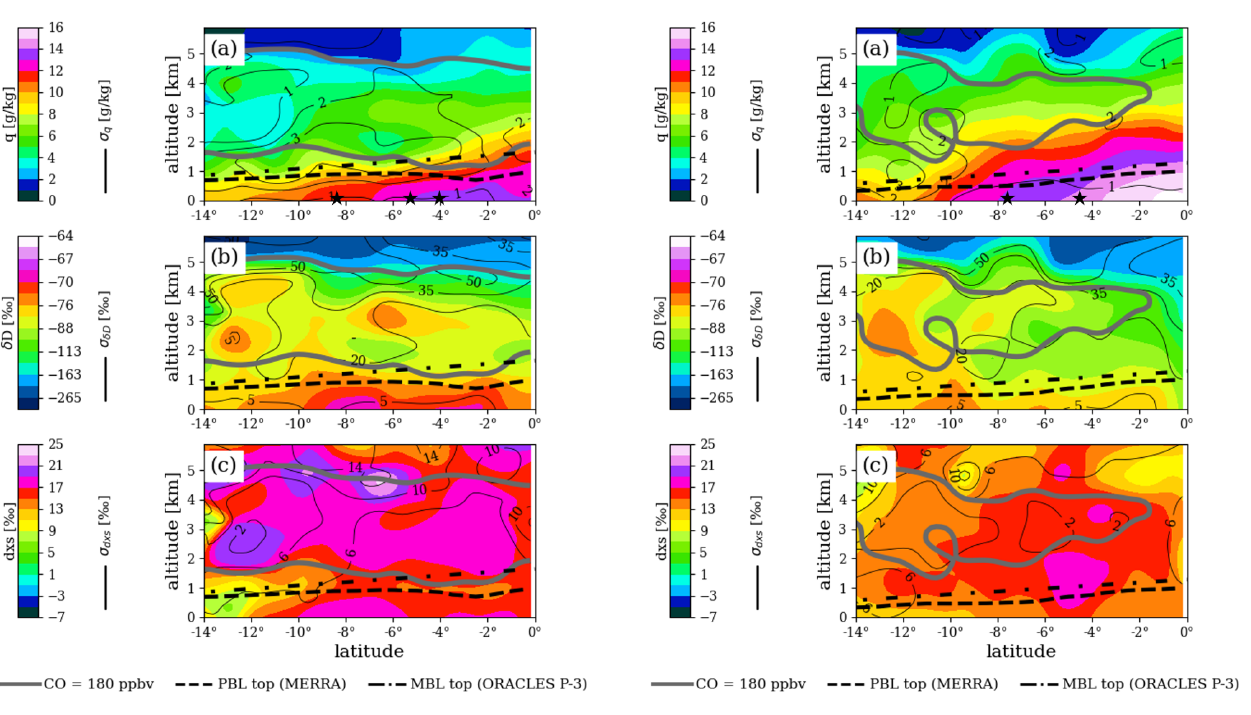
Figure 7. Same as Fig. 6 but for the ORACLES 2017 sampling pe- riod. Black stars at the bottom of panel (a) are placed at the latitudes of the three vertical profiles in Fig. 10.